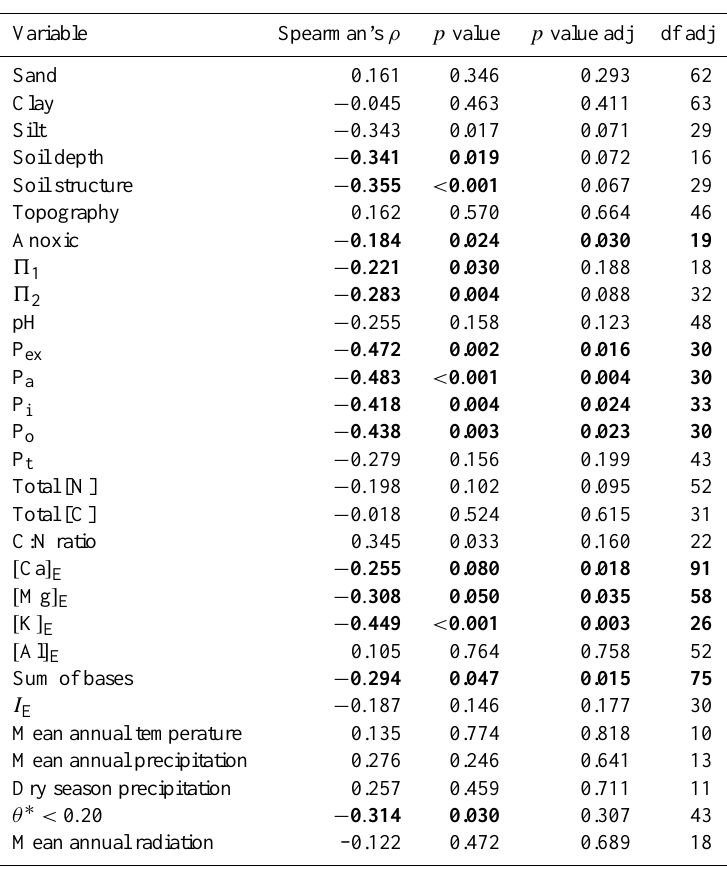
Table 7. Spearman’s ρ for relationships between above-ground biomass and a range of soil and climate predictors. Probabilities ( p ) are given with and without adjustment (adj) for degrees of freedom (df) according to Dutillieul (1993). Abbreviations used: 5 1 and 5 2 – first and second indices of soil physical conditions (Sect. 2.2); [ P ] ex , [ P ] a , [ P ] i , [ P ] o , [ P ] t – extractable, available, inorganic, organic and total soil phosphorus pools; [ Ca ] E , [ Mg ] E , [ K ] E , [ Al ] E - exchangeable calcium, magnesium, potassium and aluminium concentrations; I E – effective soil cation exchange capacity; θ ∗ < 0 . 20 – modelled number of months with soil water less than 0.2 of maximum available soil water content. Where p ≤ 0 . 050 values are shown in